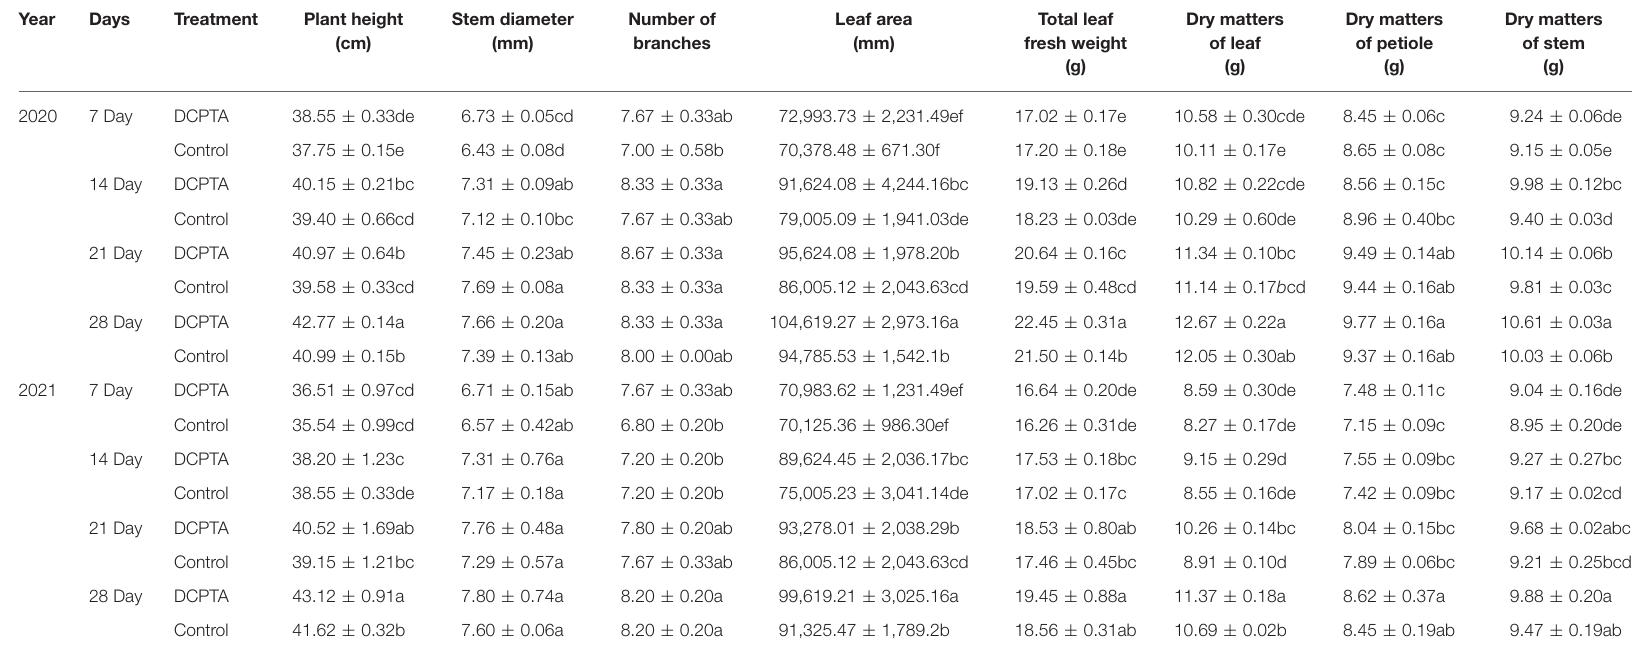
TABLE 3 | Effects of DCPTA on morphological index and the accumulation of dry matter from 2020 to